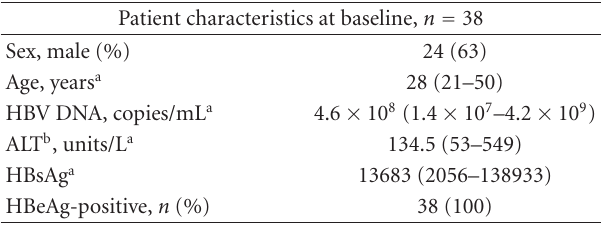
Table 1: Clinical characteristics of the CHB patients at study enroll-